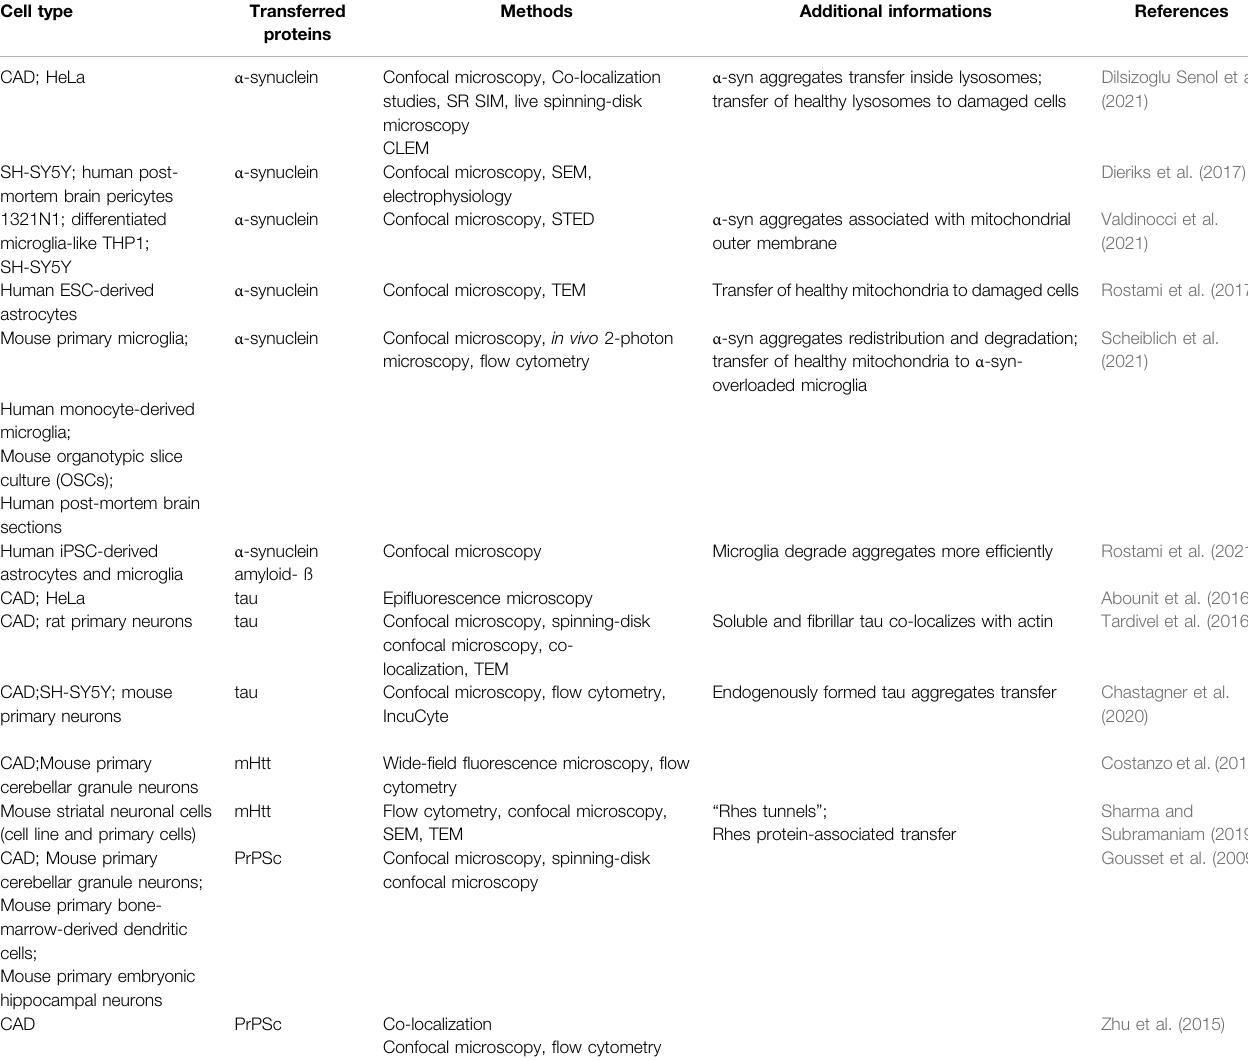
TABLE 2 | Transfer of proteins through TNTs in neurodegenerative